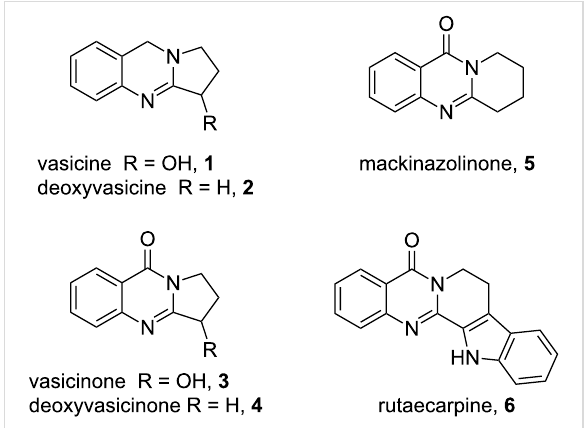
Figure 1: Examples of naturally occurring quinazoline alkaloids.